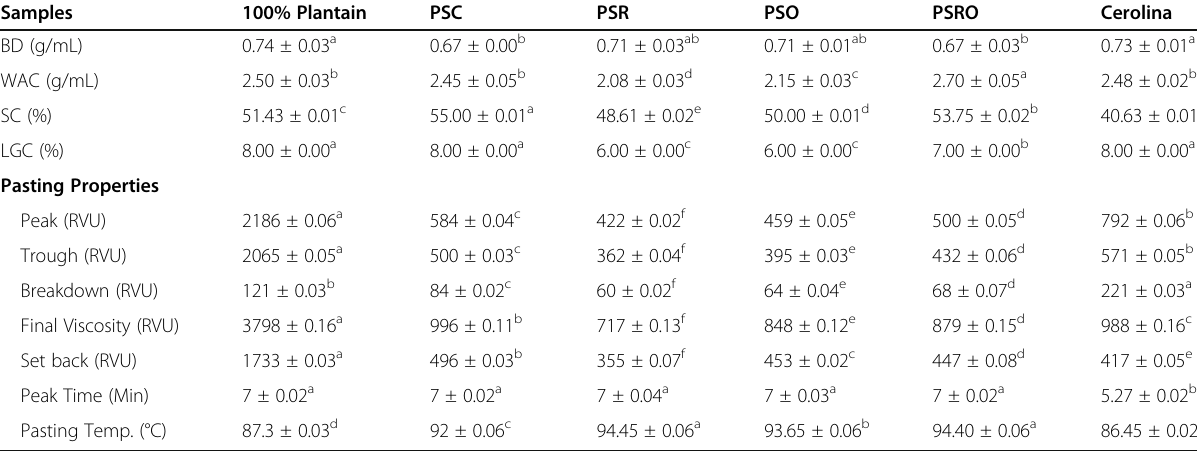
Table 6 Functional and pasting properties of plantain, soycake, rice bran and oat bran composite flour and control samples Samples